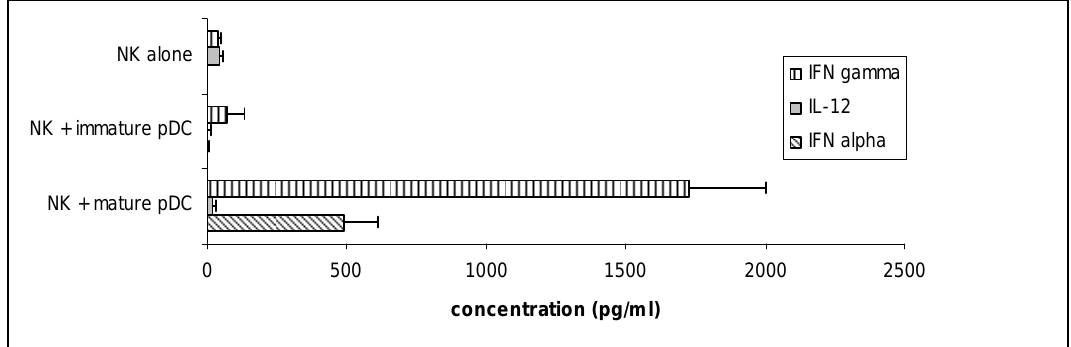
Figure 5. Mature pDC induce IFN γ secretion by NK cells.